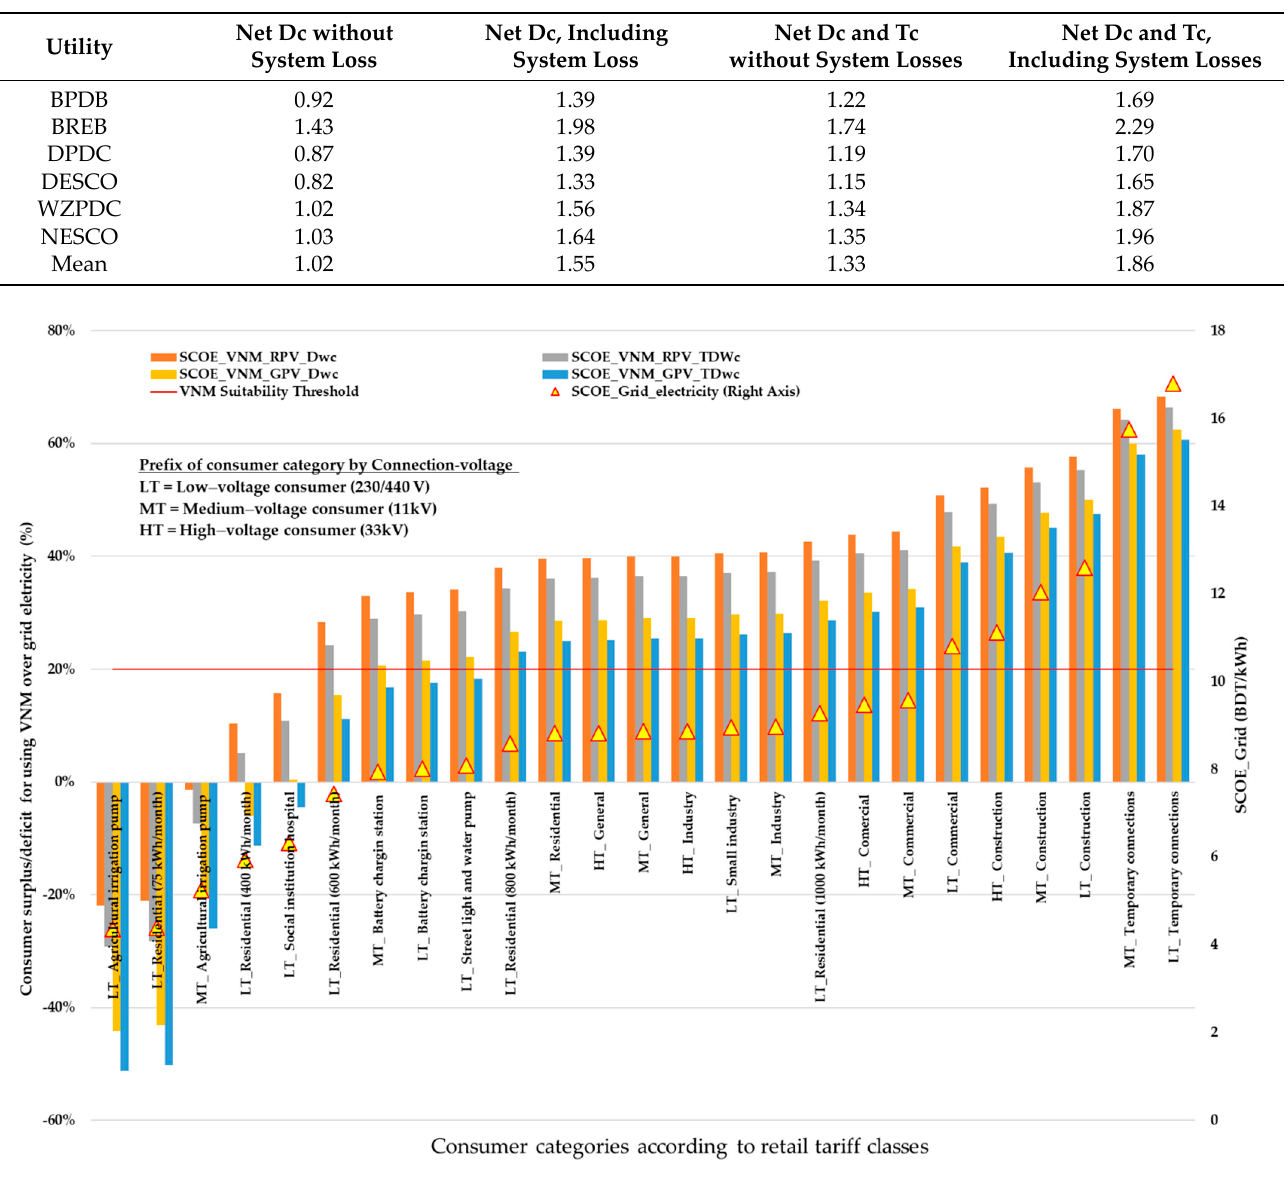
Table 8. Utility‑wise distribution and transmission wheeling costs in Bangladesh (with and without system losses).